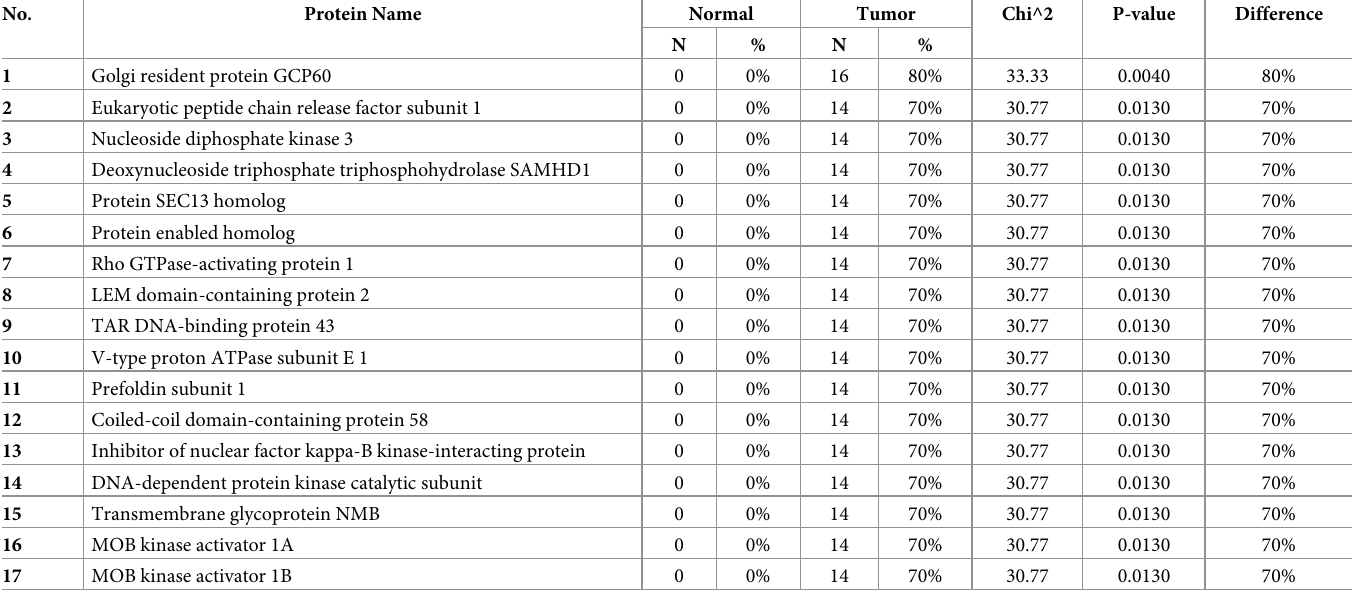
Table 3. List of proteins detected in stage 3 breast cancer